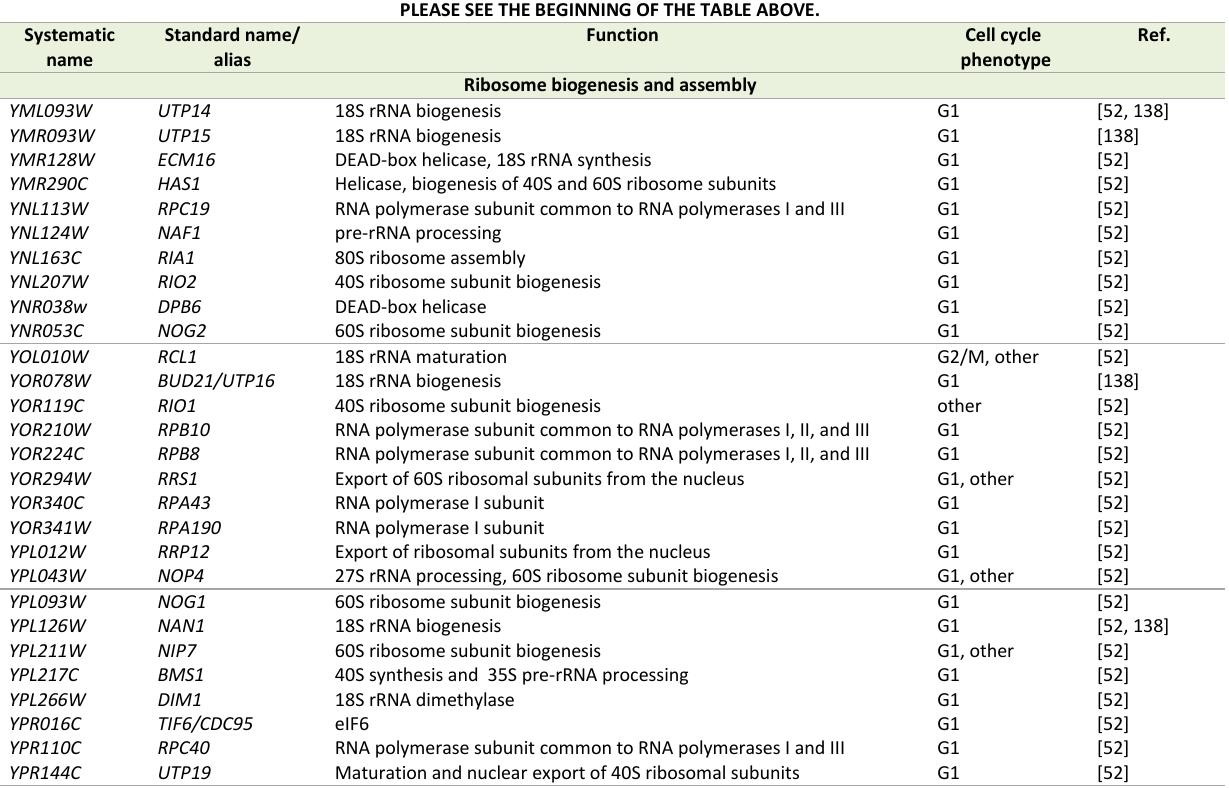
TABLE 1. Cell cycle phenotypes of loss-of-function mutants in essential genes encoding protein synthesis and ribosome biogenesis factors in S. cerevisiae. PLEASE SEE THE BEGINNING OF THE TABLE